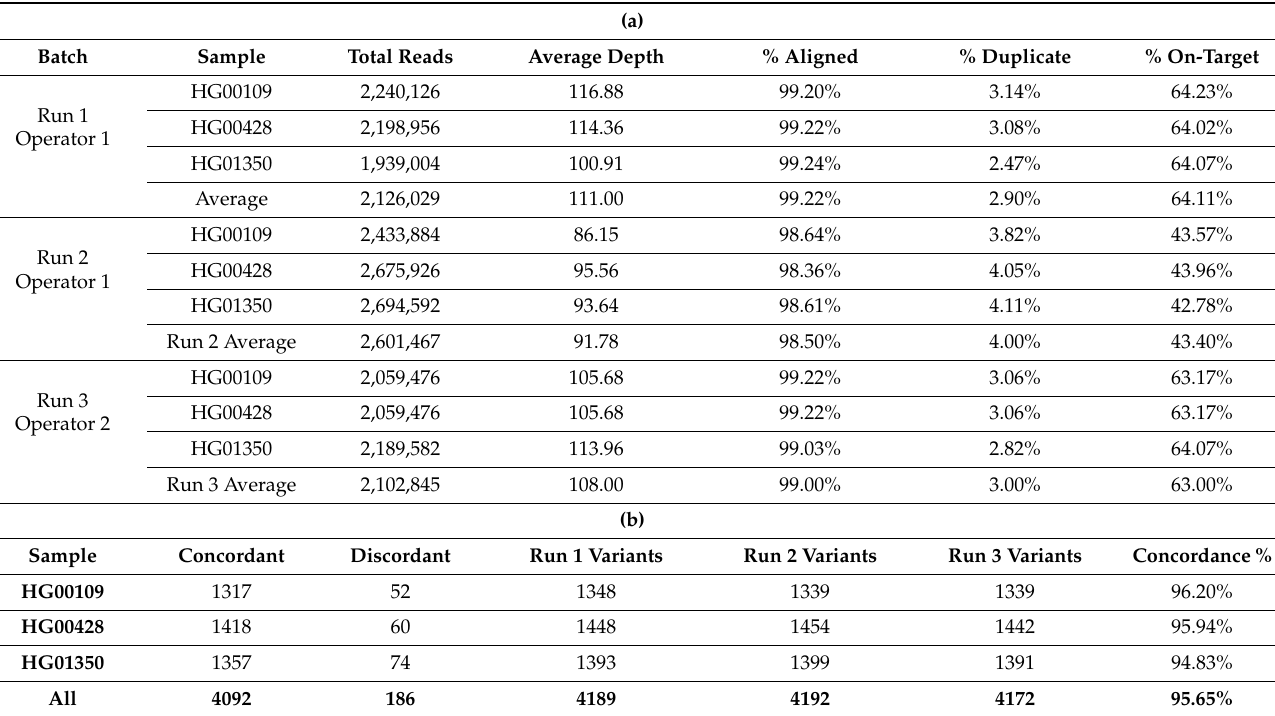
Table 4. ( a ) Inter-precision study results; ( b ) Inter-precision variant concordance. (a)